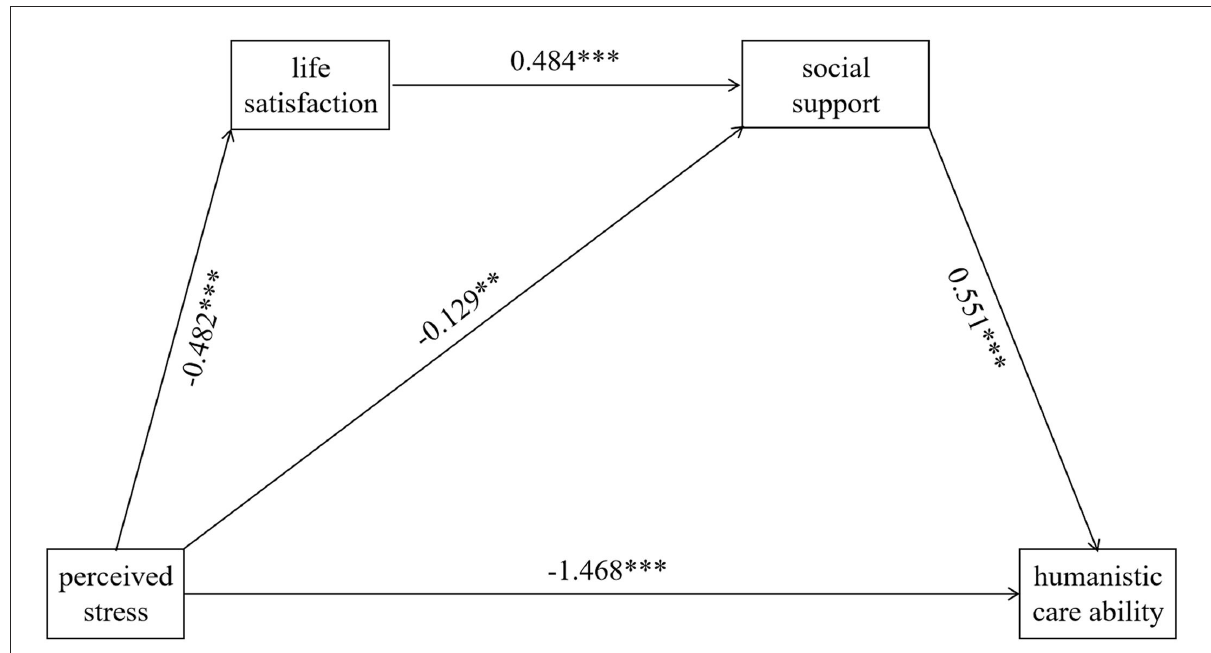
FIGURE2 The chain mediating effect of social support and life satisfaction between perceived stress and humanistic. The ** means P < 0.01; the *** means P <